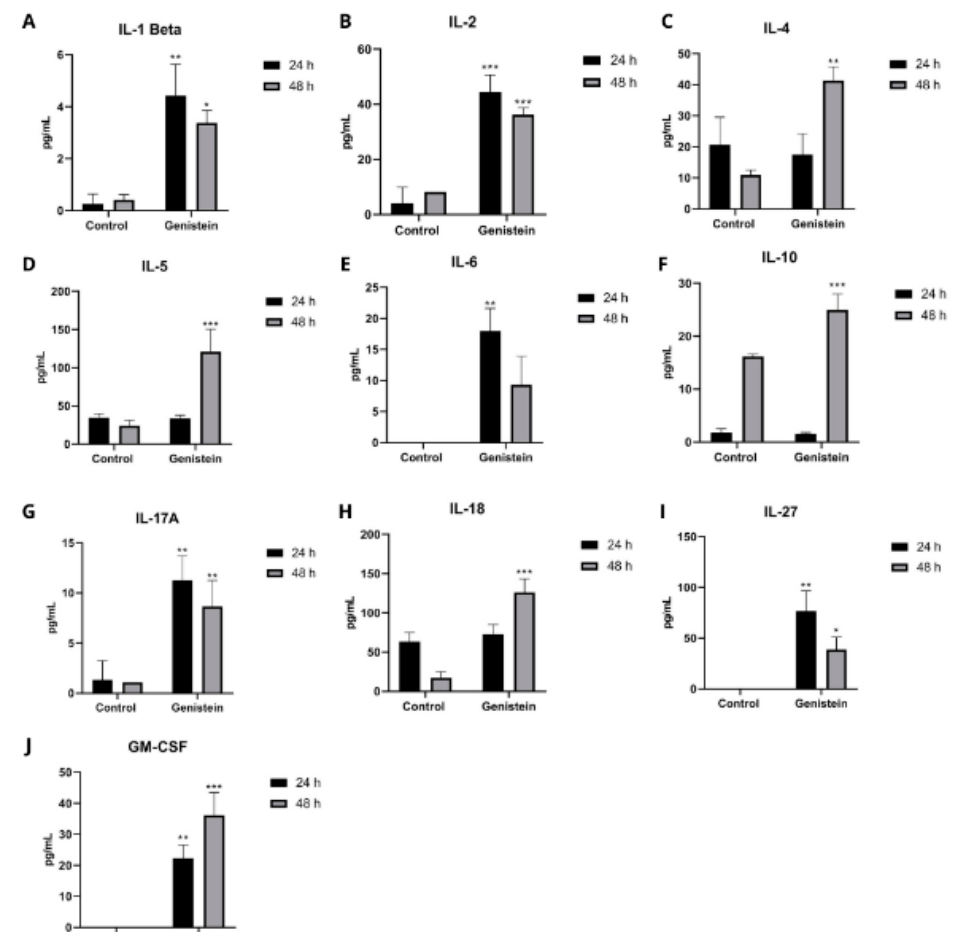
Figure 10. Effect of genistein on important cytokines in the inflammatory and carcinogenic process in SW620 cell line. Levels of each cytokine at 24 and 48 h after treatment with genistein compared to the control. ( A ) IL-1Beta. ( B ) IL-2. ( C ) IL-4. ( D ) IL-5. ( E ) IL-6. ( F ) IL-10. ( G ) IL-17A. ( H ) IL-18. ( I ) IL-27. ( J ) GM-CSF. p < 0.05 *; p < 0.01 **; and p < 0.001 ***.